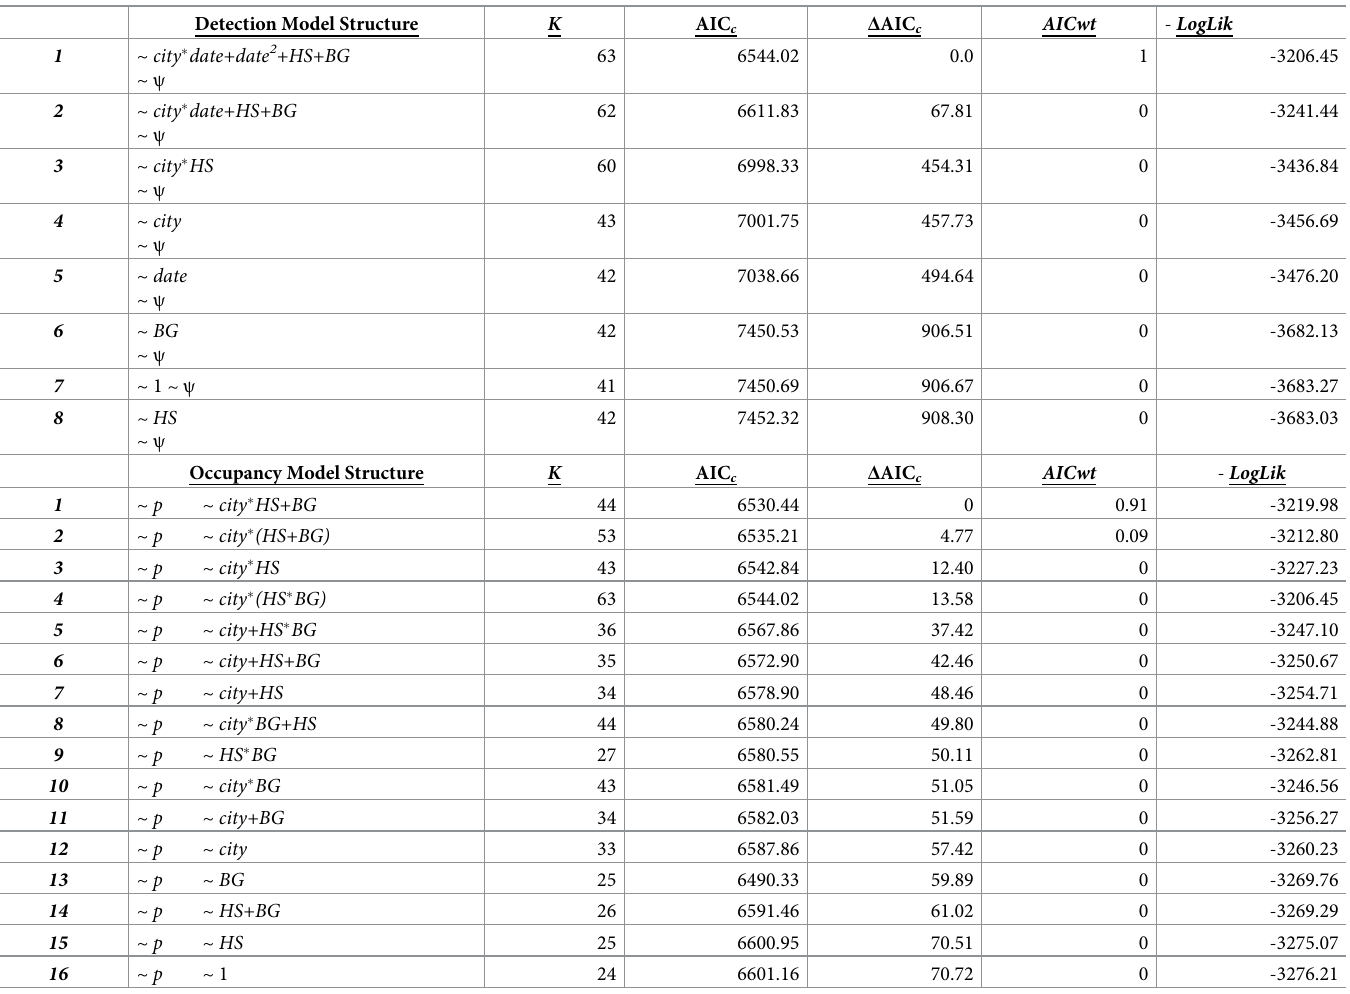
Table 4. Model selection table. Detection Model